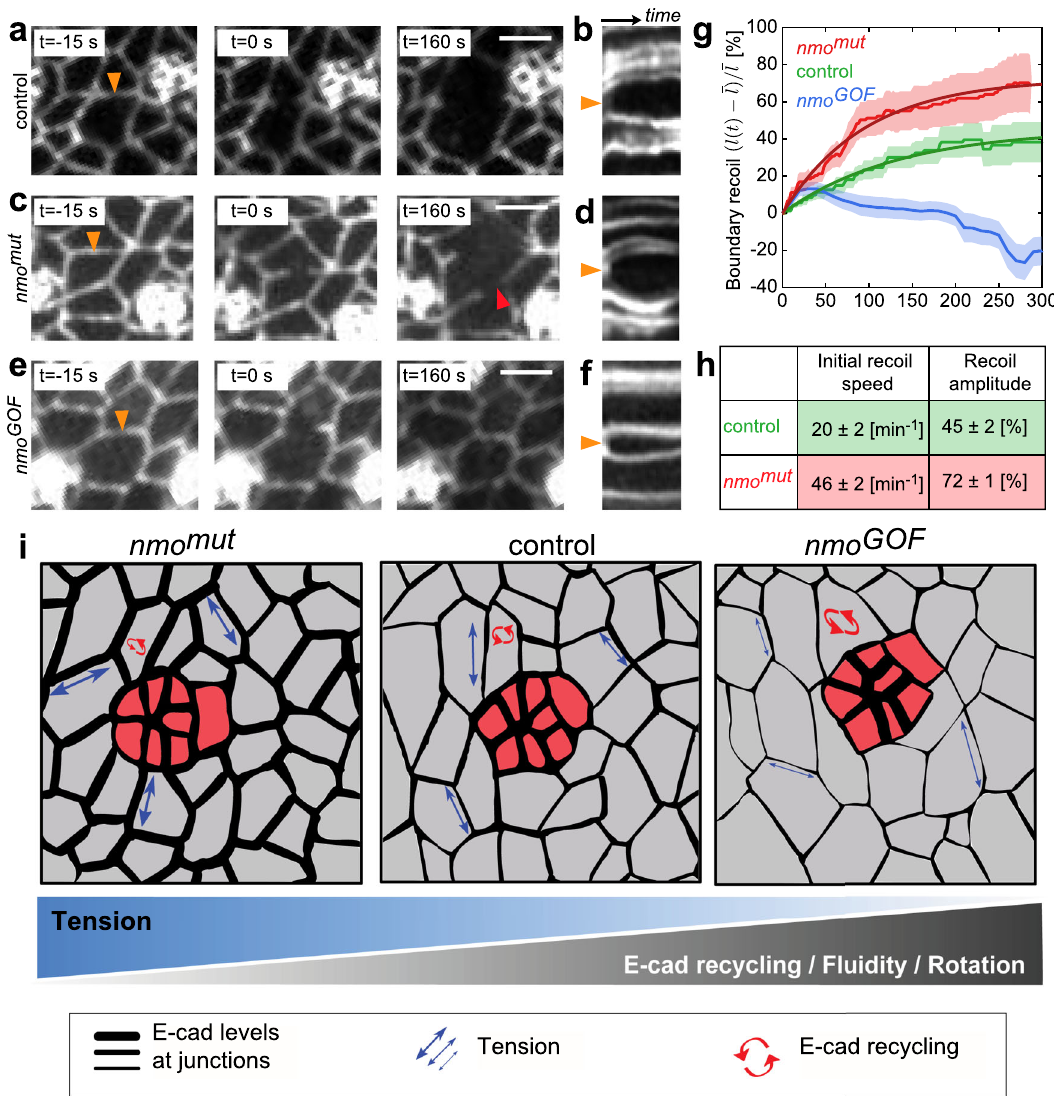
Fig. 6 Nmo regulates tissue mechanics and tension at adherens junctions. a , c , e Snapshots of laser ablation experiments performed at the level of a single junction in wt control, nmo mut (LOF), and nmo GOF conditions. Orange arrowheads indicate ablated junctions. Note that in nmo mut (LOF), the excessive pre-existing stress in the tissue causes ruptures in non-ablated junctions (red arrowhead in the right panel in c ) Scale bar: 3 µ m. b , d , f , Kymographs of ablated junctions for the respective genotypes (each pixel = 2 s). g Average boundary recoil after ablation in wt control (green, n = 5), nmo mut (red, n = 7), and nmo GOF (blue, n = 8) tissues. Line shows mean, and shaded region indicates standard deviation. Exponential fi tted curves for wt control and nmo mut are also shown. For nmo GOF , an initial expansion was immediately followed by reformation and shrinkage of the ablated boundary, and an exponential function does not correctly fi t this data. h Table showing the initial recoil speed and recoil amplitude for wt control and nmo mut measured from the exponential fi tted curves shown in ( g ). i Schematic summary of the effects of Nmo during rotation and the associated tissue fl uidity requirements for rotation. Ommatidial cluster cells are colored in red and ICs in gray in all panels. The thickness of black lines between cells, representing AJs, correlates with levels of E-cad. Blue double arrows indicate tension levels, and red circular arrows the level of E-cad recycling. As E-cad recycling and tissue fl uidity increase from nmo mut , through wt (control) to nmo GOF , tension decreases, facilitating cluster rotation in wt and ultimately allowing over-rotation in nmo GOF